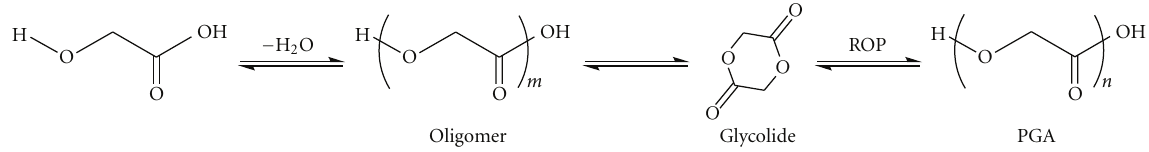
Scheme 3: General scheme of ring opening